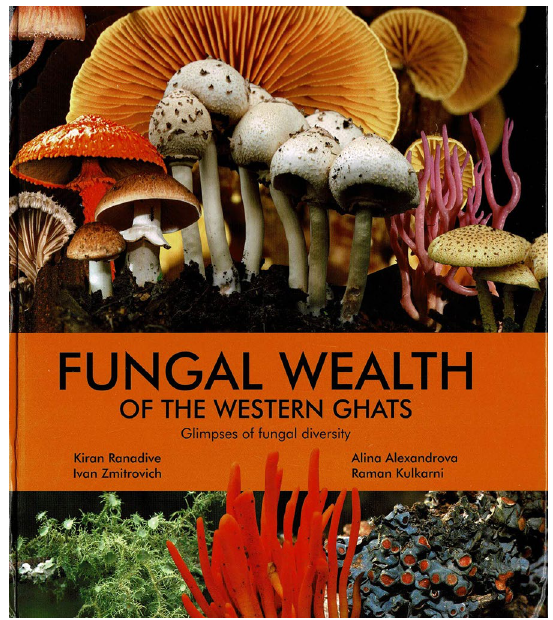
Fig. 24 Fungal wealth of the Western Ghats